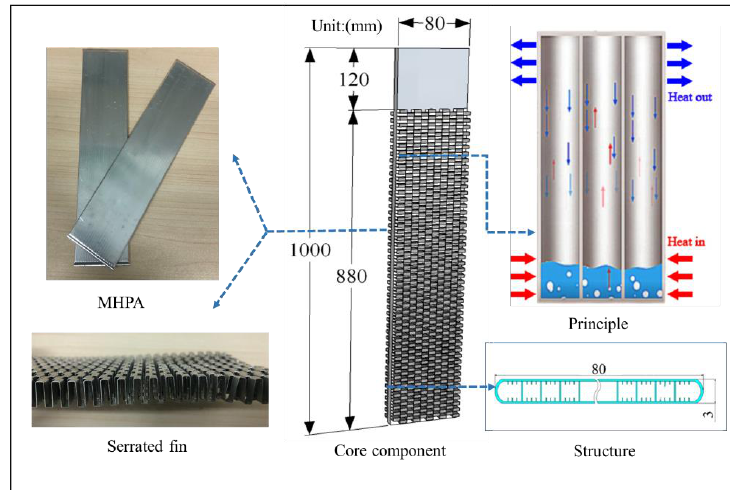
Figure 1. Core heat transfer component of the micro-heat pipe arrays air – water heat exchanger (MHPA-AWHE).